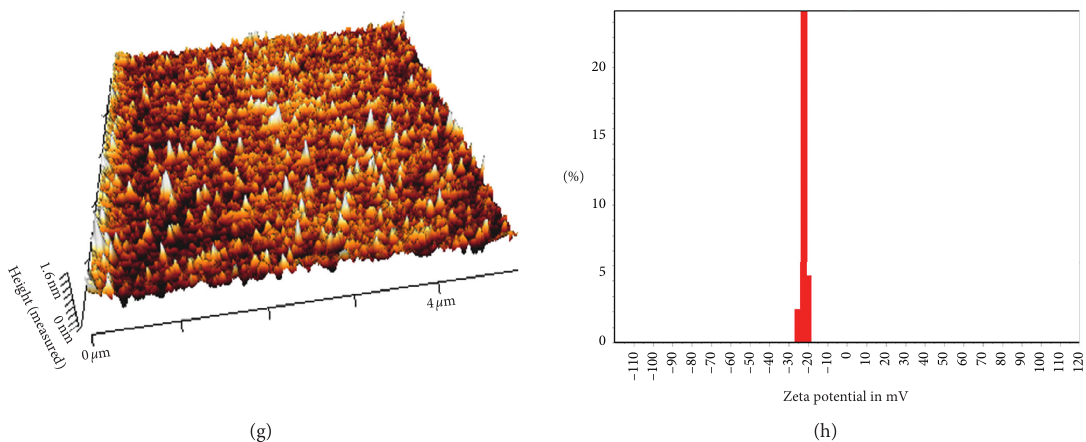
Figure 1: The green synthesized ZnO-NP characterization data. (a) The UV-vis spectra of the reaction mixture containing S. officinalis - mediated ZnO nanoparticles (ZnO-NPs). (b) Size distribution of S. officinalis ZnO-NPs as analyzed by DLS. The result showed that the nanoparticles are well dispersed, and the nanoparticles’ average size is 31.5nm. (c) The XRD pattern of S. officinalis ZnO-NPs. The nanoparticles’ XRD pattern revealed distinct peaks at 31.73 ° , 34.39 ° , 36.22 ° , 47.51 ° , 56.56 ° , 62.81 ° , 66.29 ° , 67.91 ° , and 68.98 ° . Consequently, the XRD pattern confirmed that the ZnO-NPs have a crystalline structure. (d) FTIR of S. officinalis ZnO-NPs. The peaks recognized in the nanoparticle solution describe the operative groups of the chemical compounds of S. officinalis that decreased zinc to produce the nanoparticles. (e) The field emission scanning electron microscope (FE-SEM) view of S. officinalis ZnO-NPs. The formed ZnO-NPs were observed with a scanning electron microscope to identify their forms and sizes. Based on the microscopic image, the nanoparticles have a spherical shape. (f) Energy-dispersive X-ray (EDX) spectra of S. officinalis ZnO-NPs. The absorption peak found around the 1keV shows zinc oxide nanoparticles’ configuration and appearance in the reaction mixture. (g) Atomic force microscopy (AFM) of S. officinalis ZnO- NPs. The image of AFM shows that the synthesized ZnO nanoparticle diameter was 1.6nm. (h) Zeta potential graph of S. officinalis ZnO- NPs. The zeta potential evaluated the stability of the synthesized ZnO nanoparticles. The zeta potential of the nanoparticles was found to be − 23.5mV, which indicates the nanoparticles are almost Figure 1(g) that the 3D image of ZnO-NP morphology has been spherical.